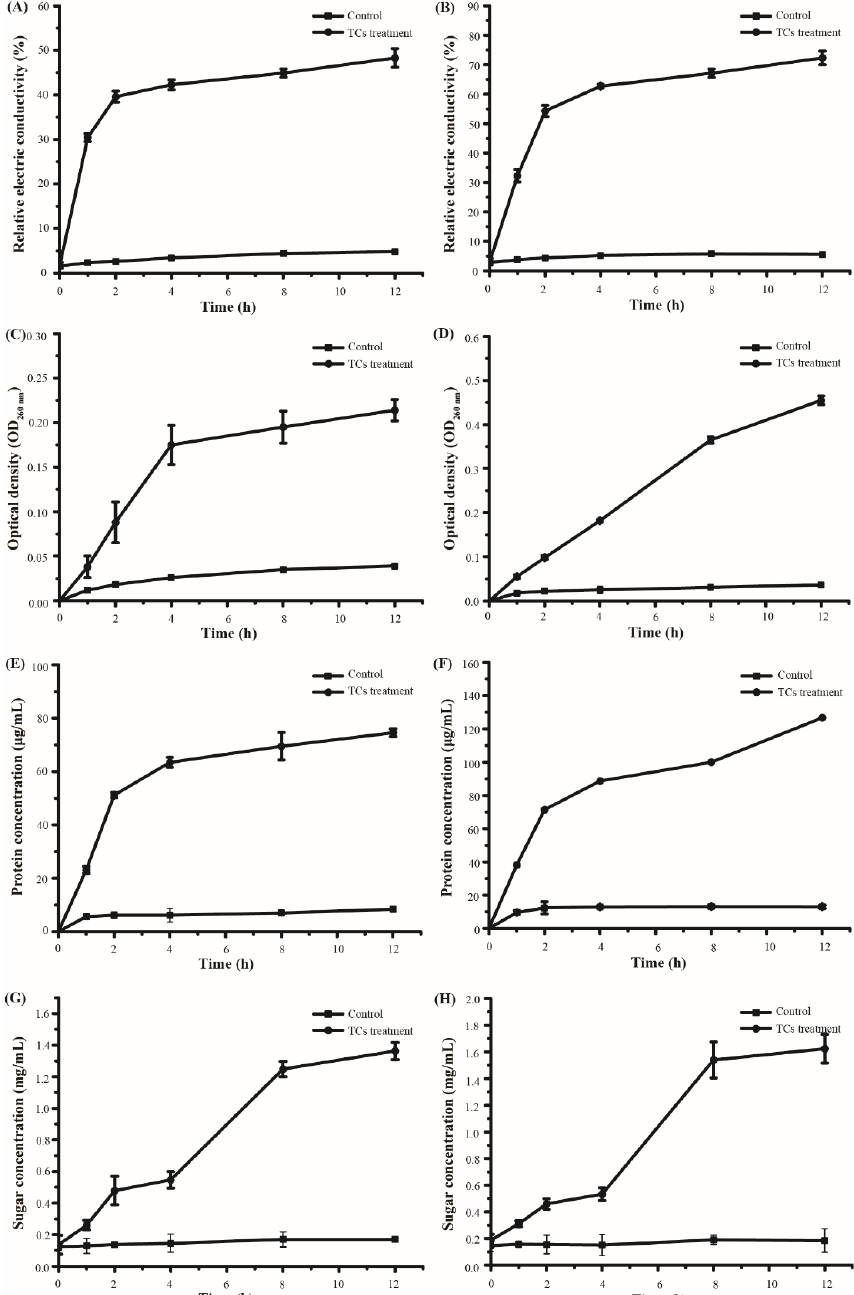
Figure 3. Effects of TCs on the membrane permeability and integrity of E. coli and S. aureus . ( A ) Changes in the relative electrical conductivity of E. coli , ( B ) Changes in the relative electrical conductivity of S. aureus , ( C ) Release of nucleic acids from E. coli , ( D ) Release of nucleic acids from S. aureus , ( E ) Release of proteins from E. coli , ( F ) Release of proteins from S. aureus , ( G ) Release of solute sugars from E. coli , and ( H ) Release of solute sugars from S. aureus